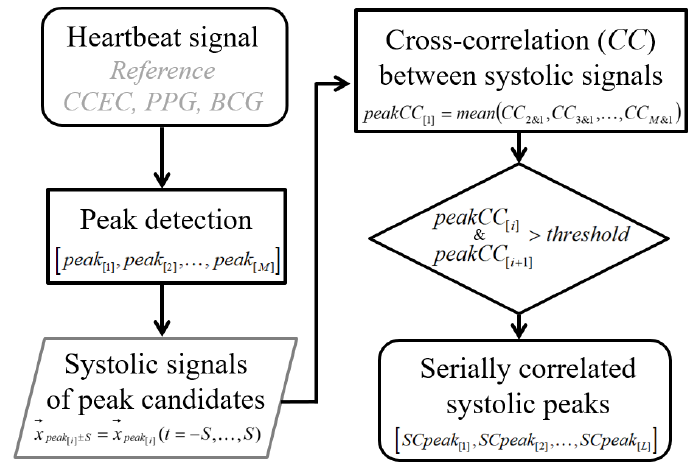
Figure 4. Preprocess to search serially correlated peaks.